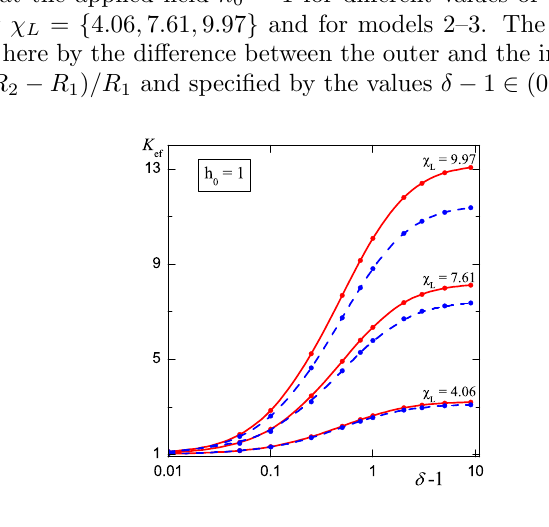
Figure 4. Dependence of the shielding effectiveness factor K ef on the dimensionless layer thickness δ − 1 = ( R 2 − R 1 ) /R 1 for the dimensionless applied magnetic-field intensity h 0 = 1 and the Langevin susceptibility χ L = { 4 . 06 , 7 . 61 , 9 . 97 } . Dashed lines correspond to model 2. Solid lines correspond to model